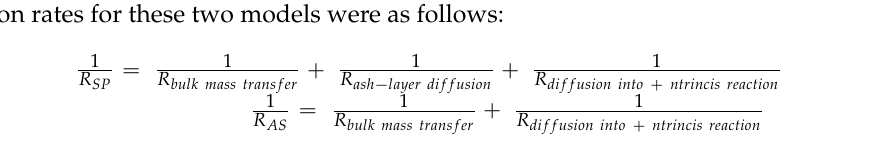
Figure 12. Different reaction regimes in packed bed model.